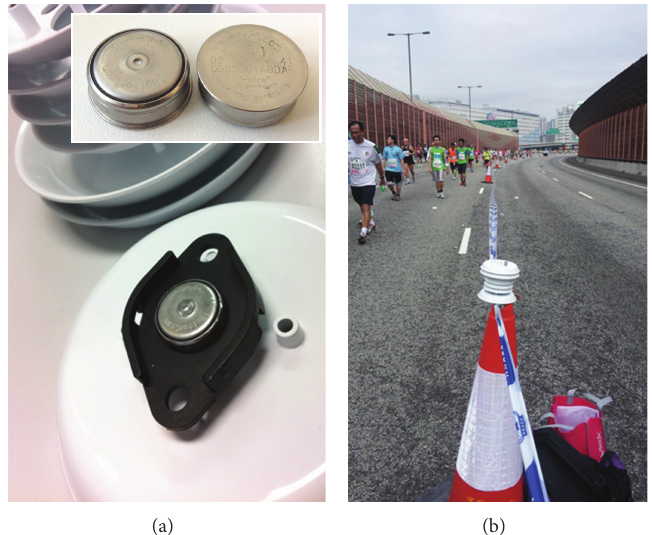
Figure 2: Temperature and relative humidity measurement and logging equipment: (a) iButton in solar radiation shield and (b) iButton in solar radiation shield installed on a traffic cone.